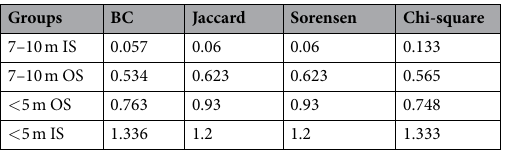
among all the groups of reefs (i.e., inner shelf 2–5 m and 8–10 m; outer shelf 2–5 m and 8–10 m). The outer shelf reefs supported 14 exclusive taxa, against one ( Padina ) in the inner shelf reefs (Fig. 2). Cluster ordination analyses performed on Bray-Curtis measures showed greater similarity in the outer reefs compared with inner shelf sites (Fig. 2). Overall, a consistent pattern emerged across the measures applied, i.e., lower heterogeneity in deeper than shallower transects and in outer than inner shelf reefs. The outer shelf reefs (particularly at the deeper transects) were mainly associated with higher cover of hard corals, soft corals and coralline algae, while most of the inner shelf reefs were associated with either upright sponges, cf. Dictyota or Sargassum (Fig. 2). For all the measures applied in the multivariate analyses, the MVDISP showed a consist- ent and increasing pattern, i.e., 2–5 m inner shelf > 2–5 m outer shelf > 8–10 m outer shelf > 8–10 m inner shelf (Table 3).